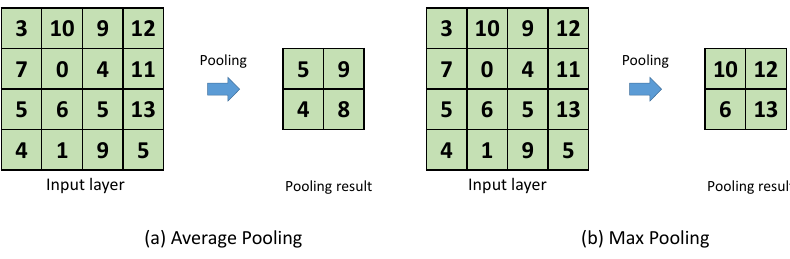
Figure 6. Operation of average pooling ( a ) and max pooling ( b ) in inference.